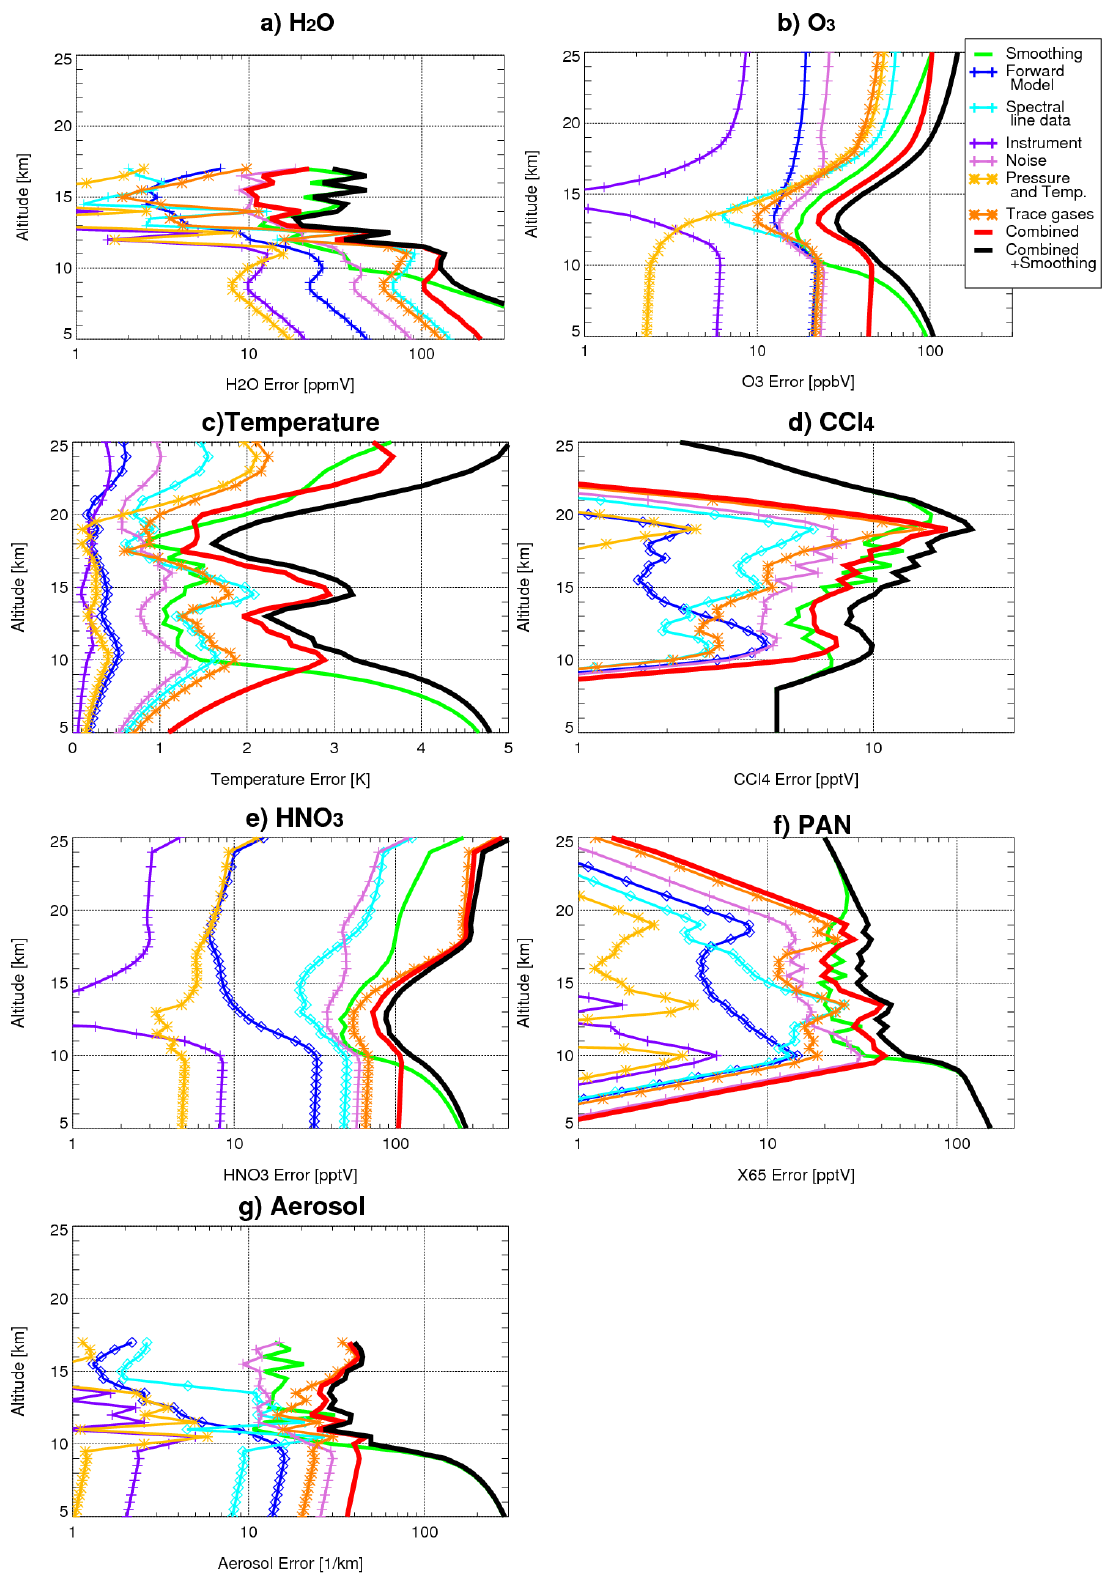
Fig. 5. Error components for H 2 O, O 3 , temperature, CCL 4 , HNO 3 , PAN, and aerosol extinction for profile 87 (forward spectra), flight L5 (y-axis